Question: Write a descriptive caption for this figure.
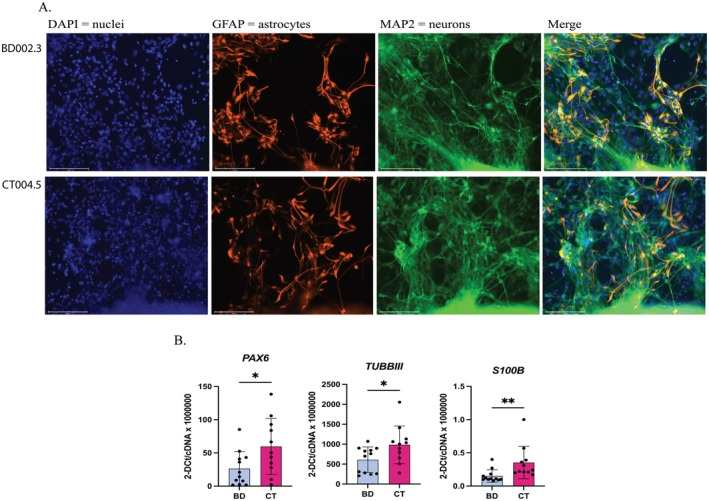
Answer: CNs characterisation. (A) Representative image of 2 cell lines neuronal and astrocytic markers. Immunofluorescence: Blue, DAPI = nuclei; green, MAP2 = neurons; orange, GFAP = astrocytes; merge. Scale bar = 150 μm. (B) QPCR results for neuroprogenitor, neurons and astrocytes. Data shows as mean in SD from the paired t ‐test for PAX6 ( p = 0.031) and β‐tubulin ( p = 0.035), and Mann–Whitney test for S100B ( p = 0.001).